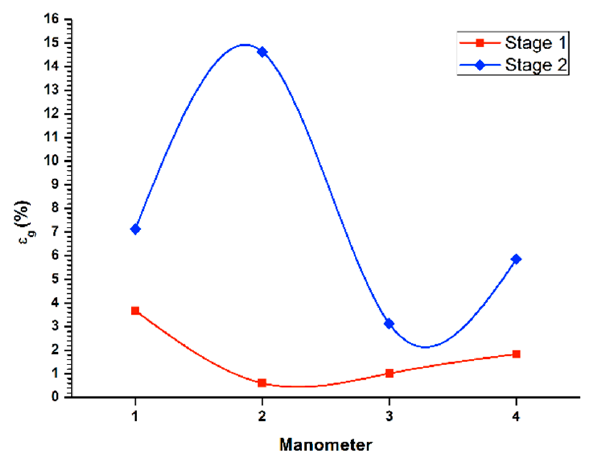
Figure 3. Determination of ε g , in the bath flotation column of the material of the “Dos Carlos” dam, for J IT of 0.446, 50 ppm of C 12 H 25 NH 2 as collector, and 60 ppm of MIBC as foaming agent. Likewise, same Figure 3 (2nd stage line) shows the determination of retained gas ( ε g ) in the columnar flotation system, for the recovery in batch system during the second cleaning stage, with a flow of liquid in the queuing stream ( J LT ) of 0.45 cm / s, applying the gas flow ( J g ) of 0.3 cm / s. In the central zone of the column (manometers 2 and 3), the highest concentration of gas retained in the system was presented, where the bubble packing has a lower acceleration. Besides, the values of gas retained at the ends of the column were similar at the top, which were slightly higher. The global percentage of gas retained was set at 15.2%.